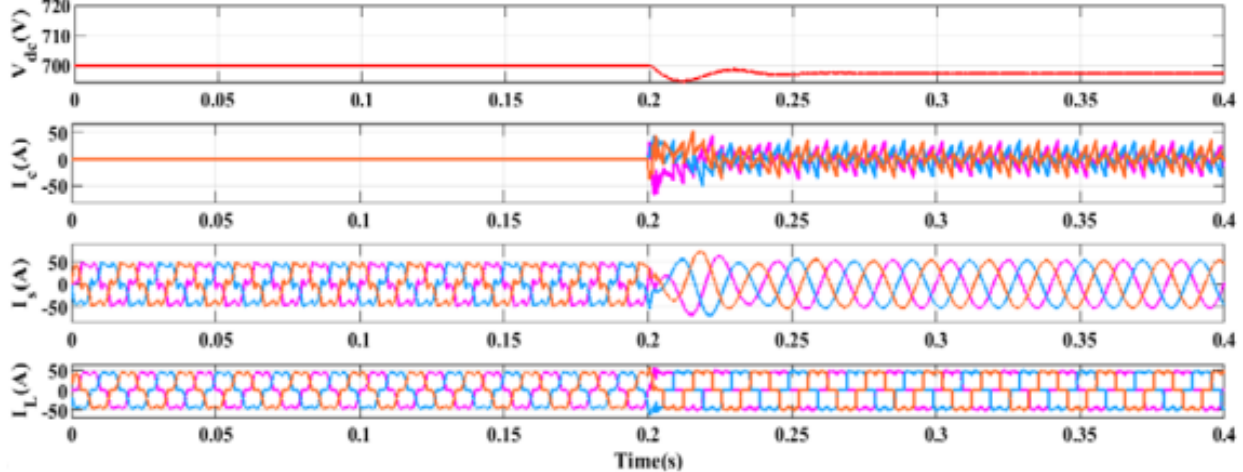
Figure 21. The behavior of enhanced SRF SOGI-FLL-based DSTATCOM with induction heating-based non-linear load.